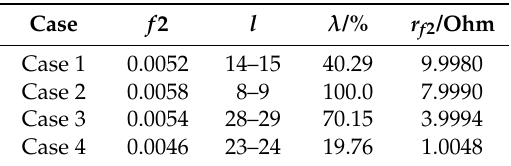
Table 5. Optimal solutions of f 2 in searching the precise location.